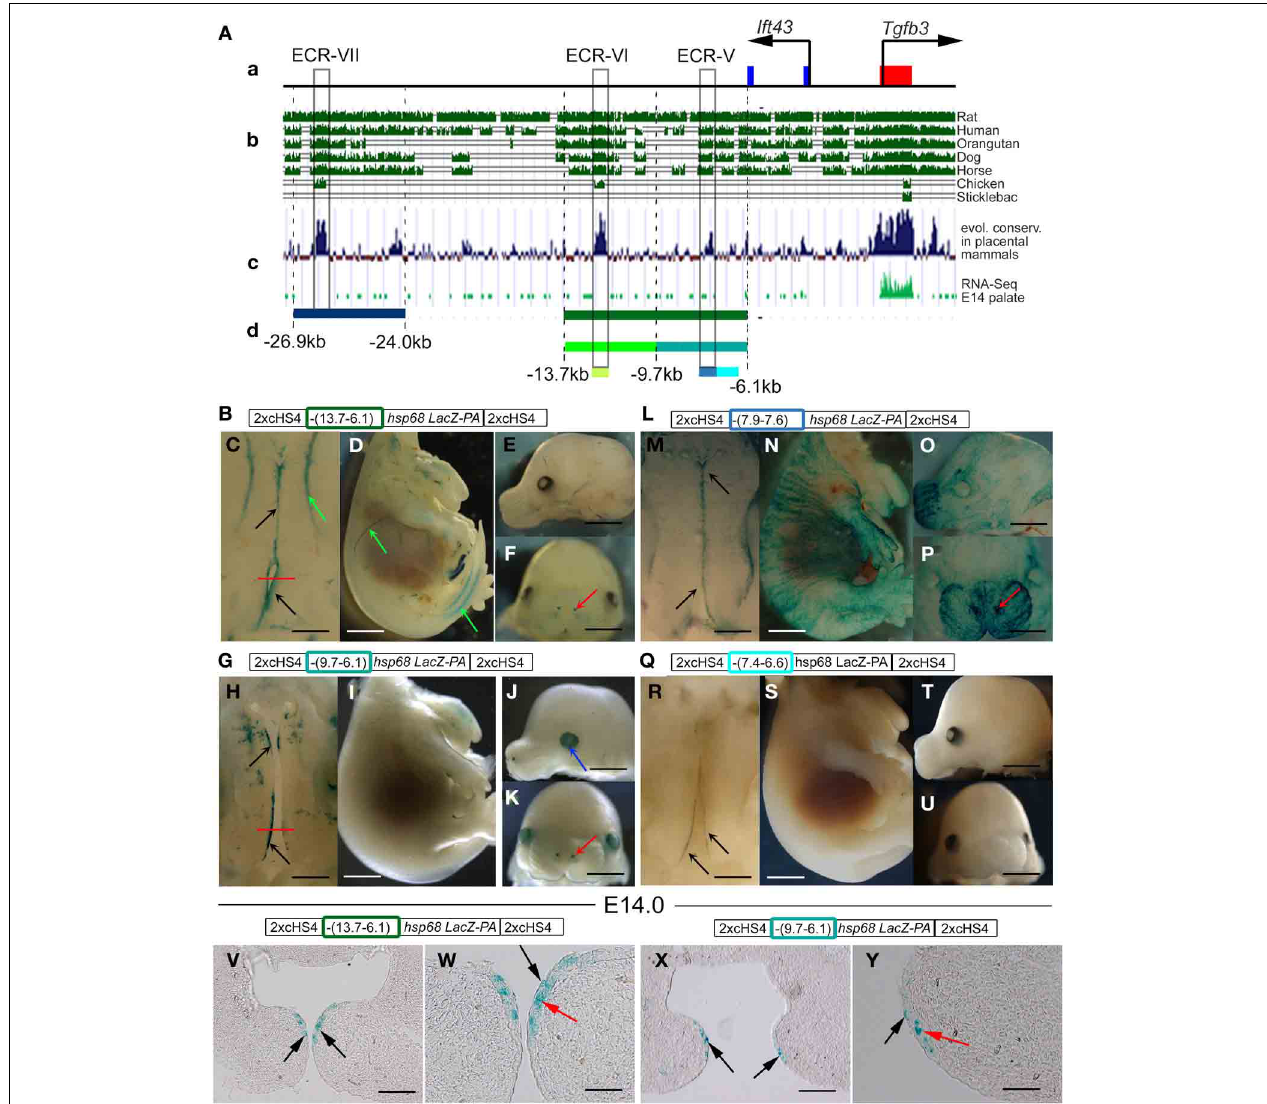
FIGURE 6 | Cis-regulatory elements targeting reporter activity to the MEE and adjacent periderm are located in intron 2 of the upstream Ift43 gene. (A) Schematic representation of a 28-kb sub-region of the 61-kb genomic fragment ( a , see Figure 4 and the main text) that includes Tgfb3 exon 1 (red box) and exons 1 and 2 of the Ift43 gene (blue boxes), aligned with (b) evolutionary sequence conservation among selected vertebrate species (UCSC genome browser), and (c) among placental mammals (UCSC genome browser), and (d) RNA-seq profile in mouse palate at E14.5 (FaceBase Enhancer Project; A Visel) used to identify the positions of non-coding evolutionary conserved regions (ECRs-V, -VI, and -VII: gray boxes). Colored bars below (d) correspond to DNA fragments (see also Figure 3 ) examined by transient transgenic reporter assay in constructs shown schematically above images of the stained embryos generated (B–Y) . (C–F) Transgenic reporter embryos carrying a 7.6-kb DNA fragment from − 13.7 to − 6.1kb (green bar below (c) and green rectangle in construct schematic) showing β -gal activity (blue staining) in tips of palatal shelves ( C , black arrows), blood vessels ( C,D , green arrows) and nostrils ( F , red arrow). (H–K) Transgenic reporter embryos carrying a 3.6-kb DNA fragment from − 9.7 to − 6.1kb (blue-green bar below (c) and blue-green rectangle in